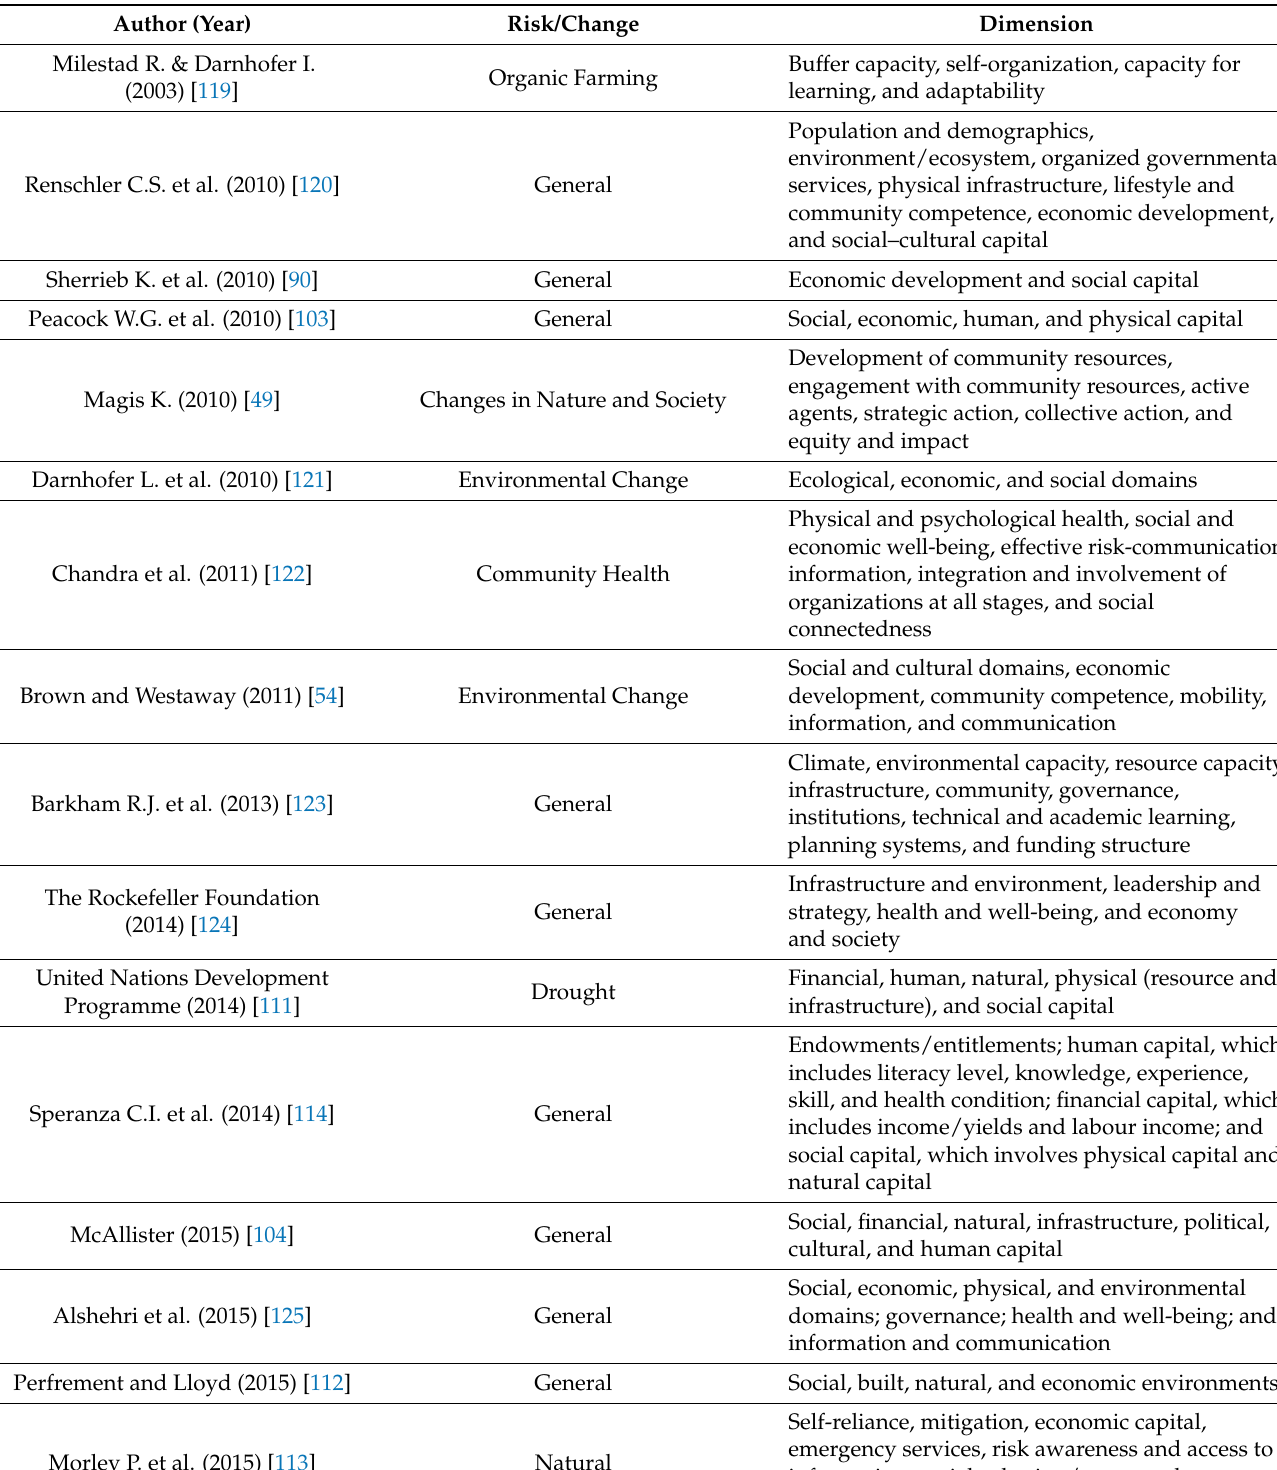
Table A1. Resilience